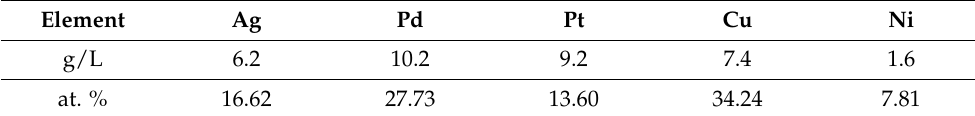
Table 3. ICP–OES analysis of suspension with CCNPs.